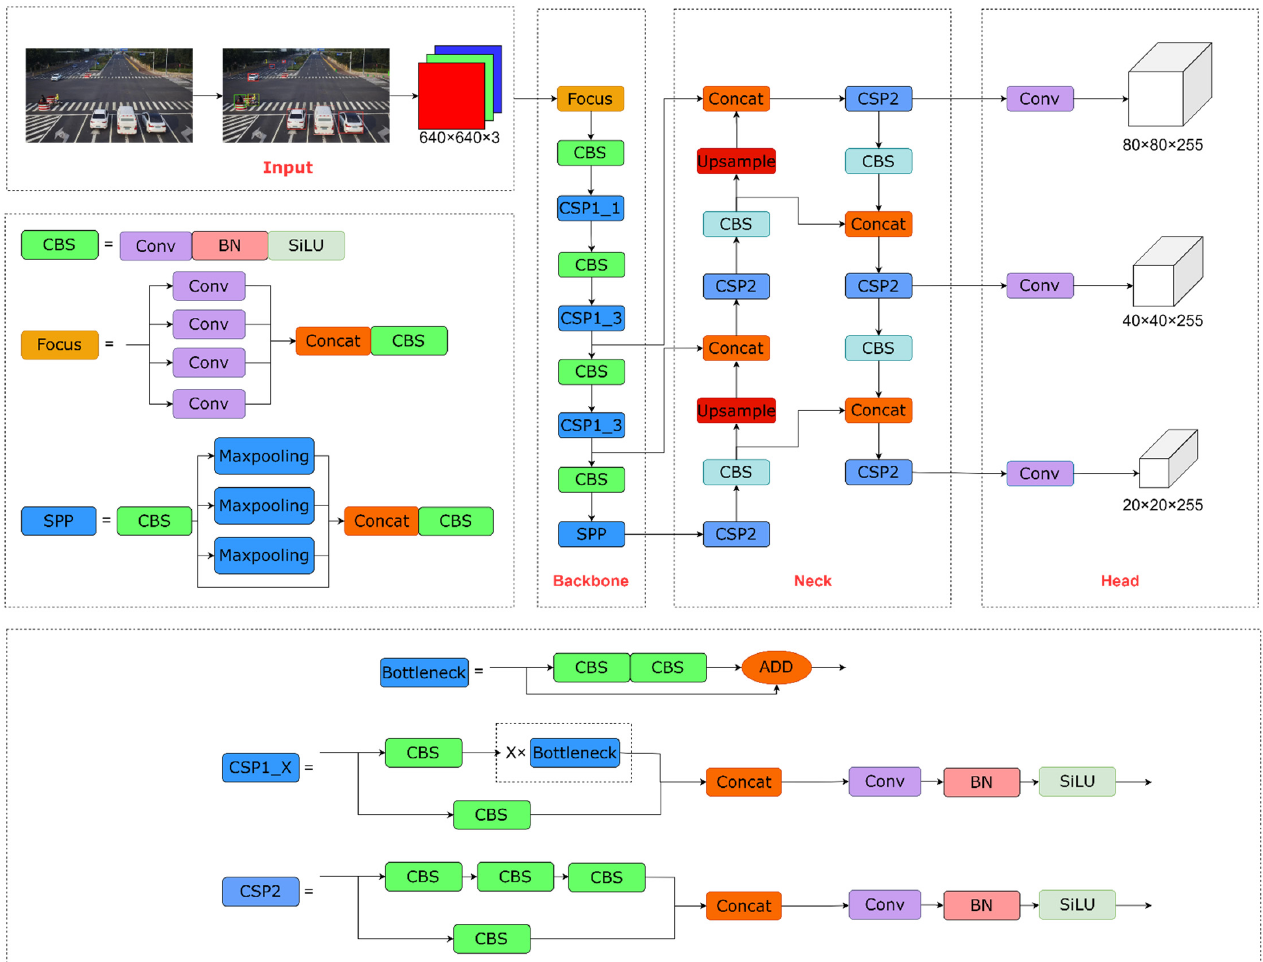
Figure 2. YOLOv5s network